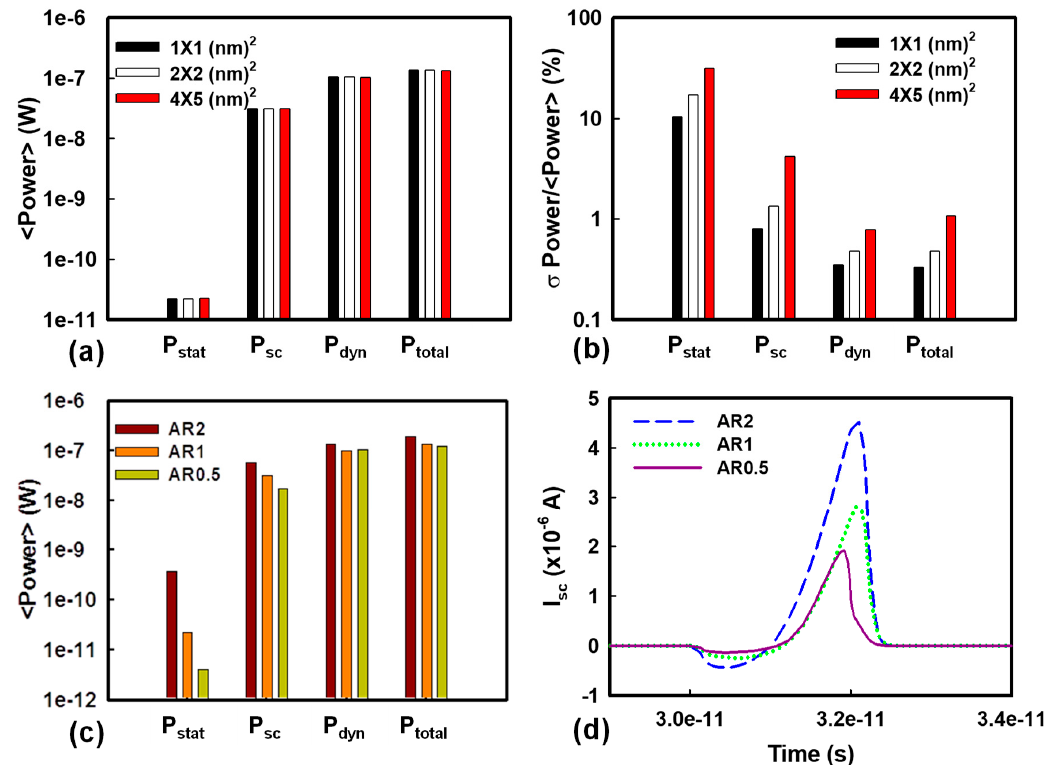
Figure 7. ( a , b ) Plots of each fluctuated power consumption experiencing WKF of the tested circuit with different grain sizes. ( a ) The average and ( b ) the coefficient of variance of power consumption. ( c ) The average power consumption induced by WKF of the tested circuit with different ARs. ( d ) The short-circuit current of the circuit with AR2 (blue dashed line), AR1 (green dotted line), and AR0.5 (purple solid line), respectively.